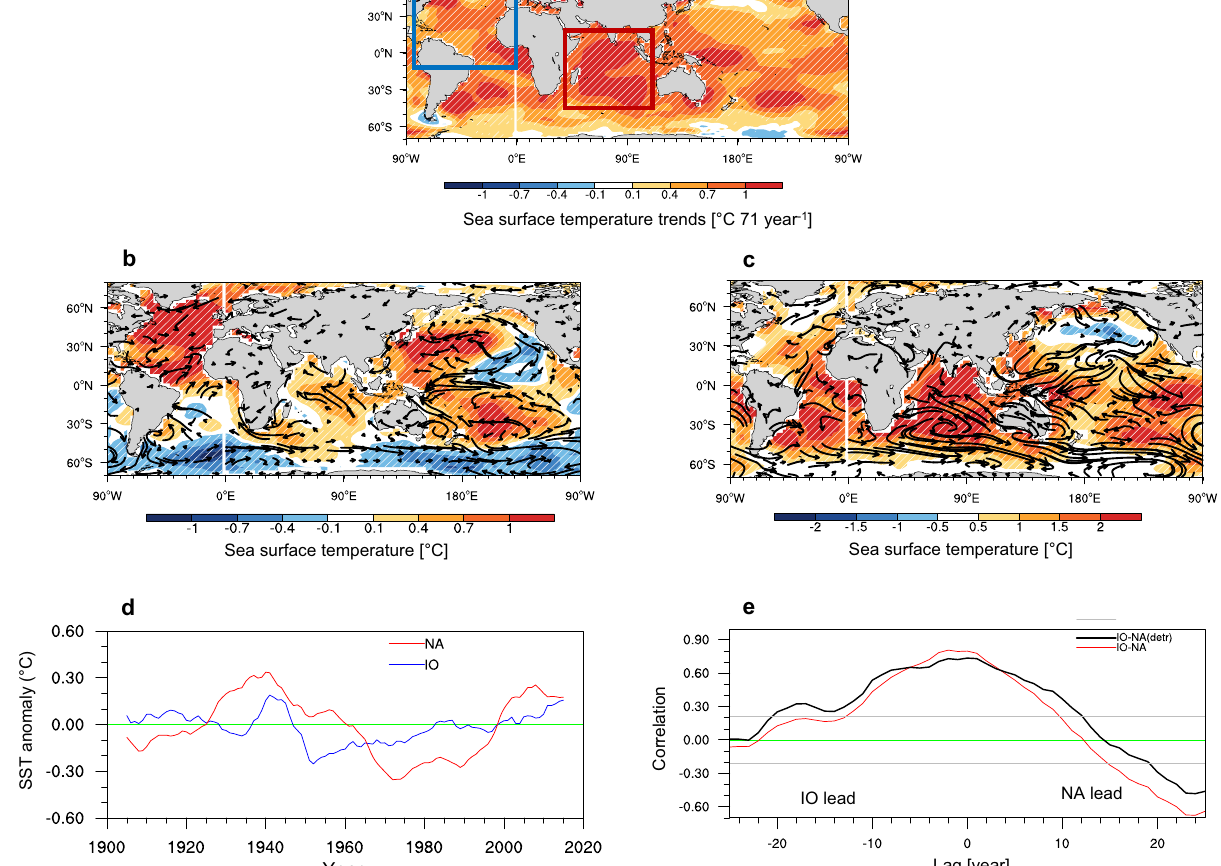
Fig. 1 Historical warming trends. a Observed trends (1950 – 2020) in annual-mean sea surface temperature (SST; units: °C 50 year − 1 ). The red (blue) box represents the region where the Indian (North Atlantic) Ocean index was de fi ned. Observed SST (K) and surface wind anomalies (arrow, m/s) regressed onto ( b ) the North Atlantic Ocean (NA) index (0° – 70°N, 80° – 0°W) and ( c ) Indian Ocean (IO) index (30°S – 30°N, 40° – 120°E). The hatched area represents the regressed SST and is signi fi cant at the 95% con fi dence level. d Observed time series of the NA (red line) and IO (blue line) indices. e Observed lead-lag correlation coef fi cient between the IO and NA indices. The lag is positive (negative) when the IO leads (lags) and the grey lines represent a 95% signi fi cance level. For b - d , the 11-year running average data were used for 1950 – 2020 and long-term linear trends were removed. For e , the last 5 years were excluded from the analysis, and the long-term linear trends in the SST data were removed before regression for the only black